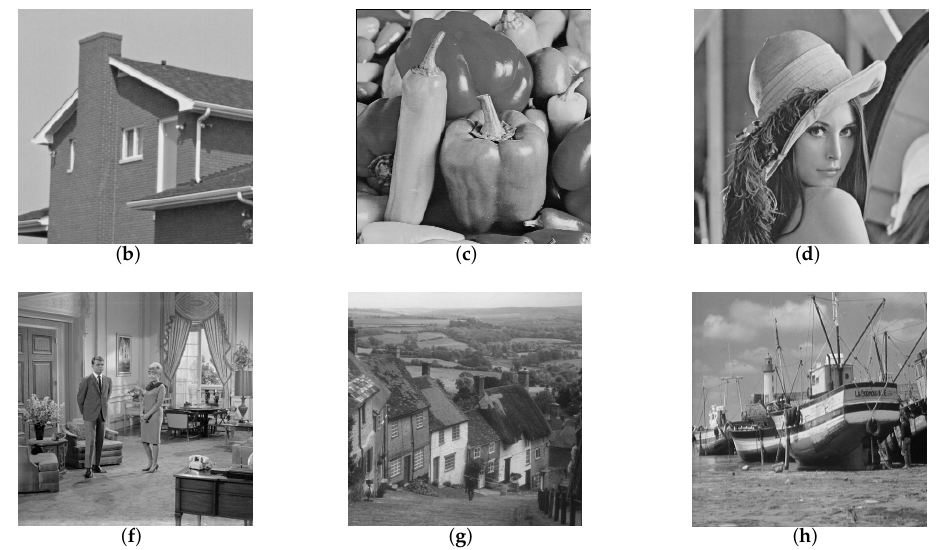
Figure 1. Eight test images used in our experiments. ( a ) Cameraman. ( b ) House. ( c ) Peppers. ( d ) Lena. ( e ) Barbara. ( f ) Couple. ( g ) Hill. ( h ) Boat.